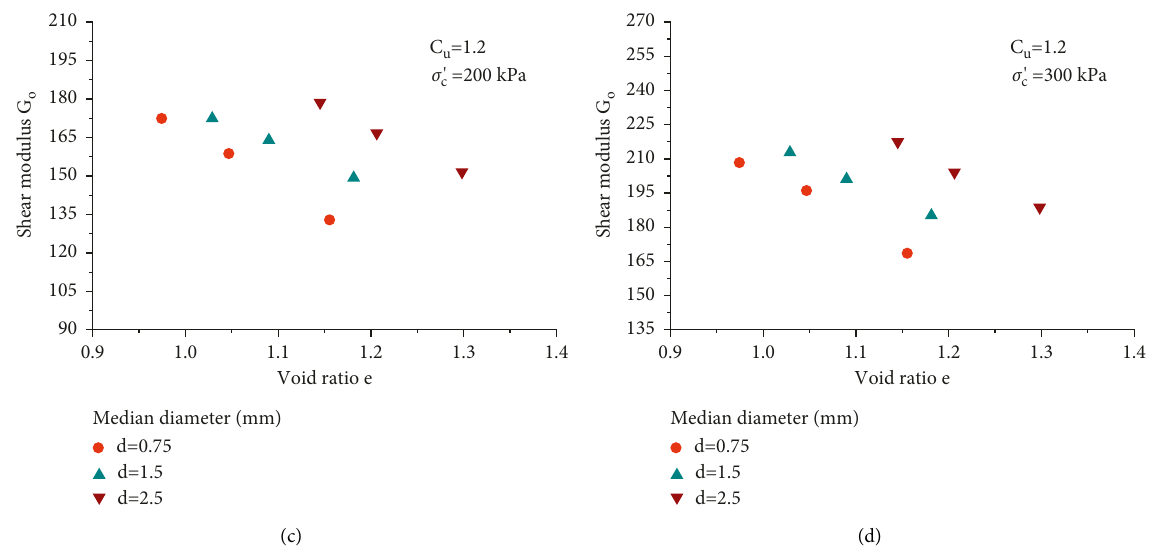
Figure 9: Maximum shear modulus and void ratio for calcareous sand with Cu � 1.2. (a) 50kPa, (b) 100kPa, (c) 200kPa, and (d)